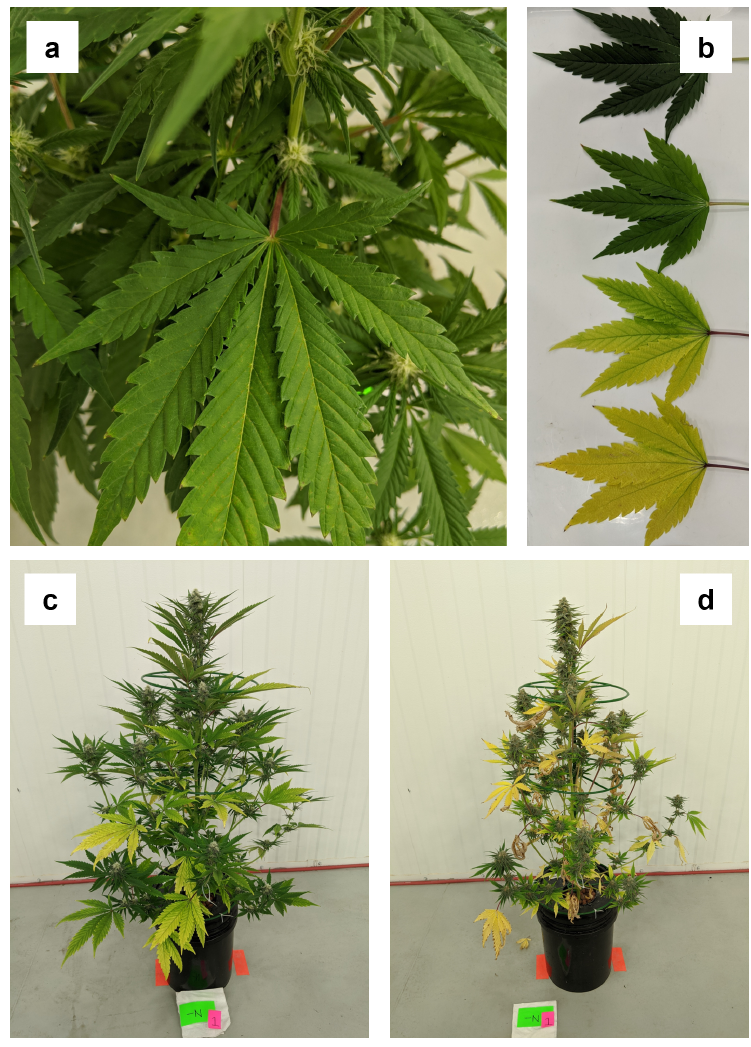
Figure 2. ( a ) Lower canopy foliar tissue of nitrogen (N) deficient plants starting to yellow during week three, ( b ) progression of nitrogen deficiency symptoms on fan leaves from mild ( top ) to severe ( bottom ) during week four, ( c ) whole leaf chlorosis developing in fan leaves of the lower two-thirds of the canopy by week four, and ( d ) almost entire senescence of fan leaves, stem browning and yellowing, and beginning of sugar leaf chlorosis in nitrogen deficient plants during week